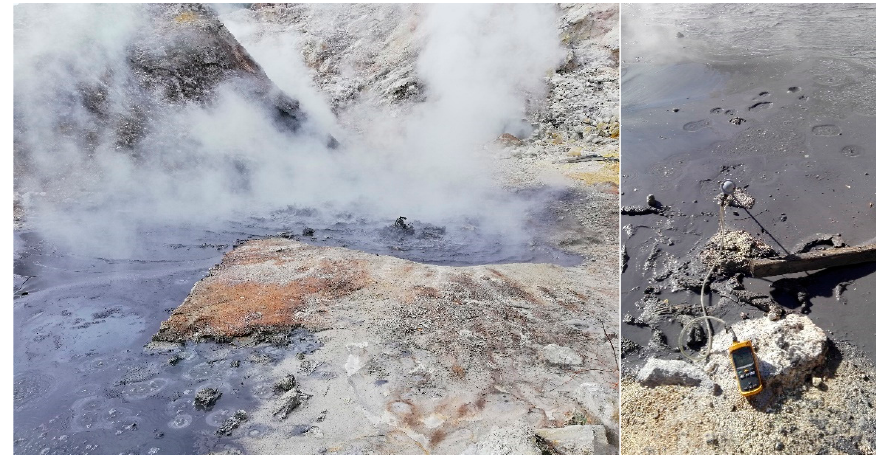
Figure 1. Pisciarelli sampling site showing an intense hydrothermal activity and the puddle water (left) and mud (right) collected.